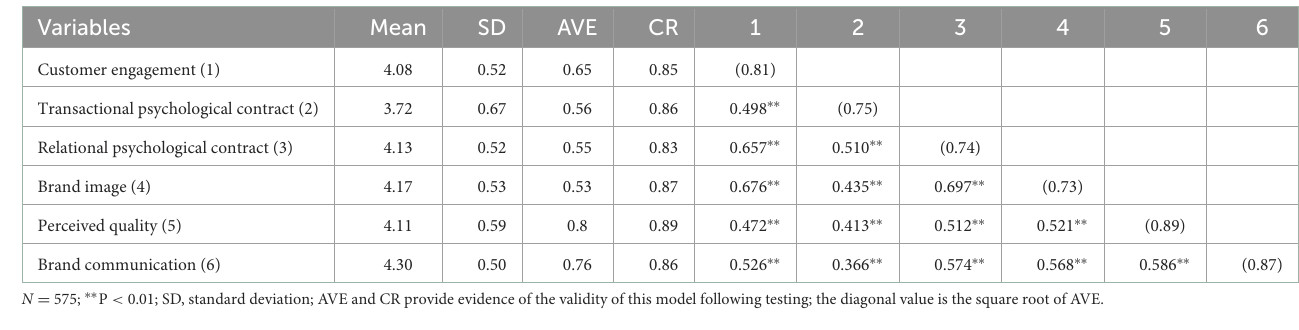
TABLE 4 Descriptive statistics, convergent, and discriminant validity.